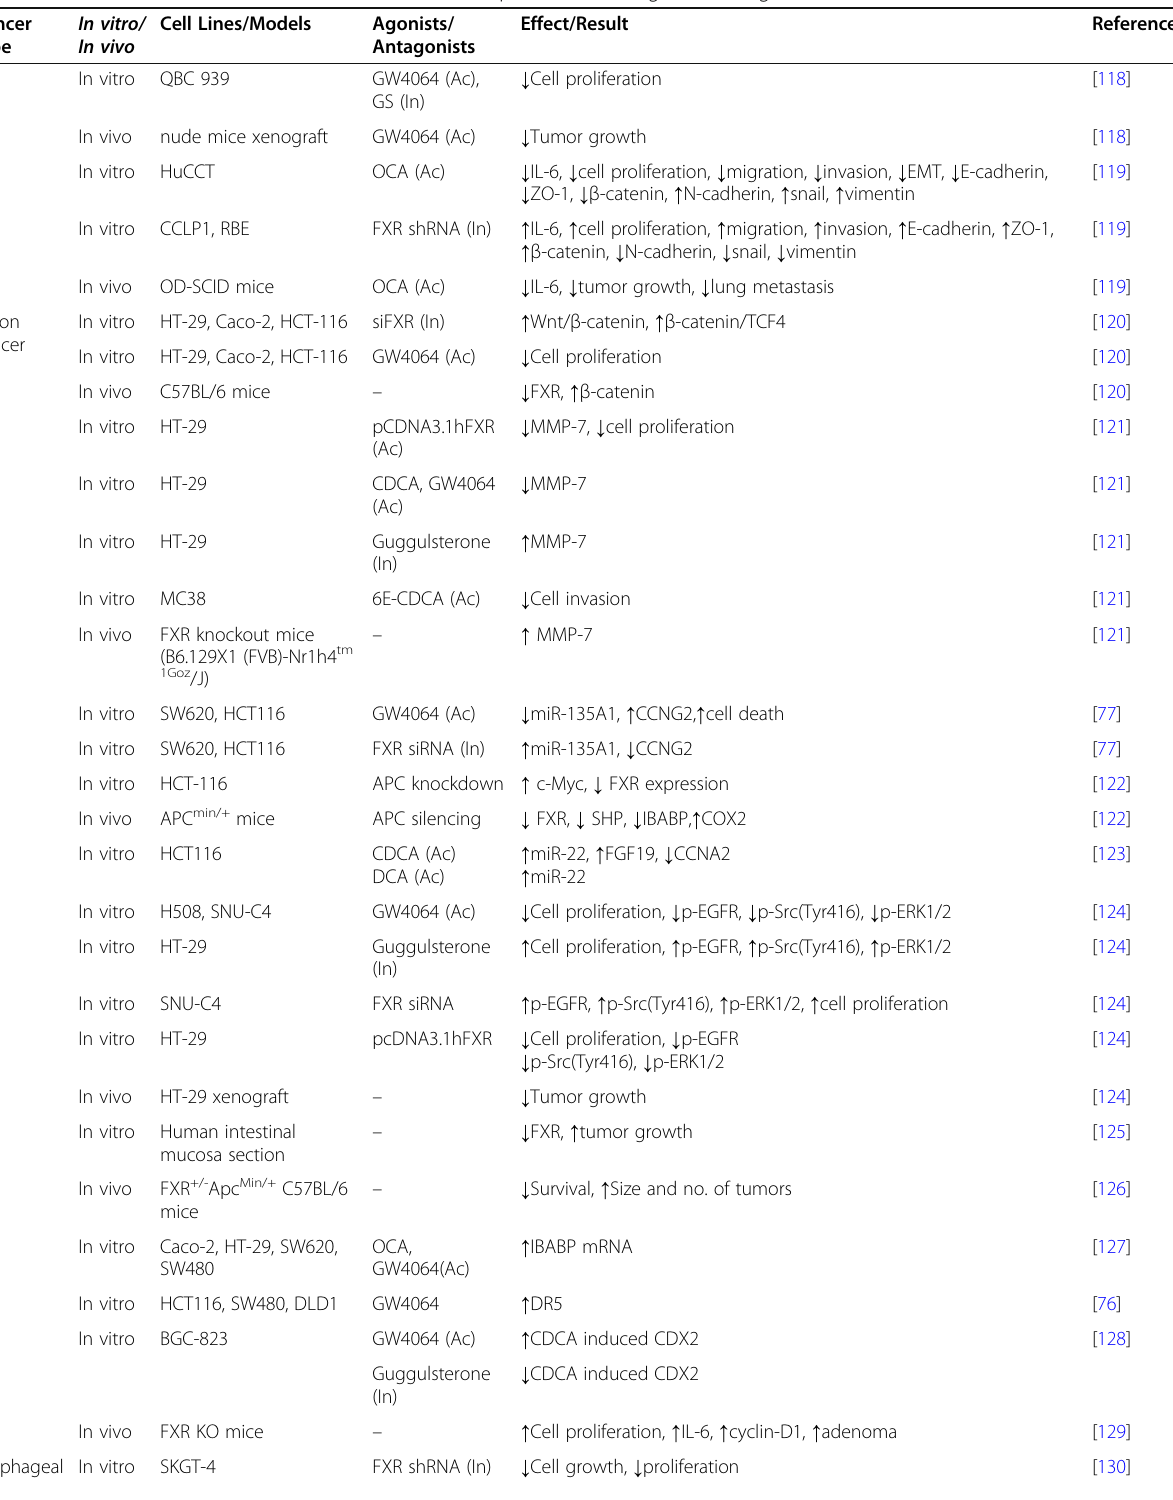
Table 1 Mechanistic role of FXR in various cancers in the presence of its agonists/antagonists (Continued) Cancer